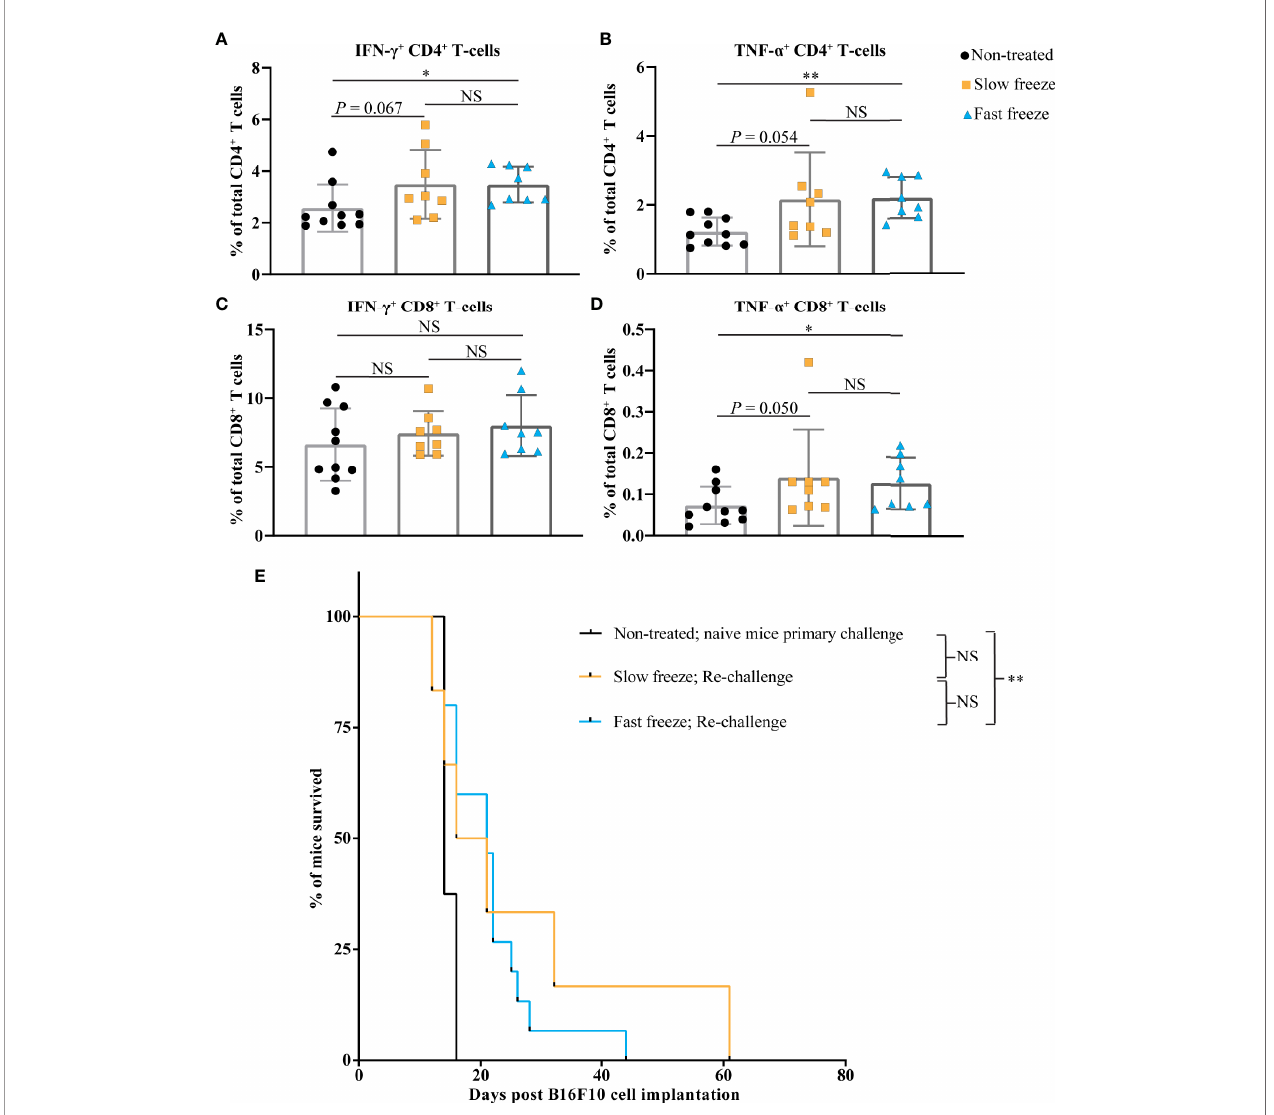
FIGURE 5 | Cryoablation by fast freeze rate induces immune responses and extends the survival post re-challenge. (A – D) Spleens isolated at day 7-8 post cryoablation, along with non-treated controls. Splenocytes stimulated in vitro for 6 hours with PMA and ionomycin. (A, B) Percentages of interferon- g + and tumor necrosis factor- a + cells within total CD4 + T-cell fraction. (C, D) Percentages of interferon- g + and tumor necrosis factor- a + cells within total CD8 + T-cell fraction. Data plotted as mean and ± S.D. obtained from three independent experiments (n=8-10). (E) Cryoblation-treated tumor-free surviving mice were subjected to re-challenge with 5 x 10 6 B16F10 cells on the contralateral fl ank between 60-70 days post primary melanoma cell transplant. Kaplan-Meier survival curves of mice post re- challenge, which previously received fast freeze (n=15) or slow freeze (n=6) ablation treatments, along with naive mice (n=8) that received melanoma cells for the fi rst time. Data plotted was obtained from three independent experiments, and analyzed using log-rank (Mantel-Cox) test. * P < 0.05, ** P < 0.01, NS, not signi fi